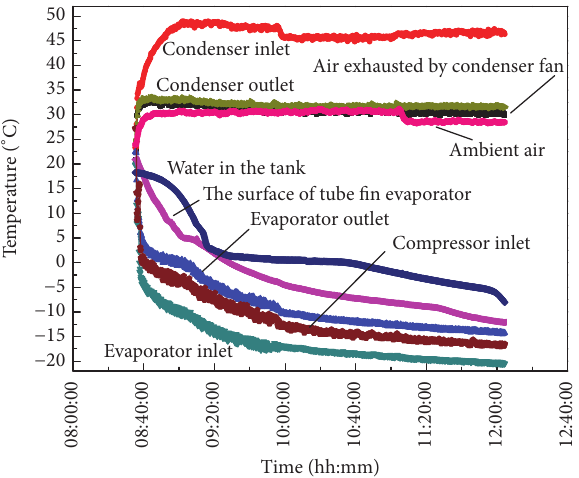
Figure 19: Temperature changes of ice maker components after